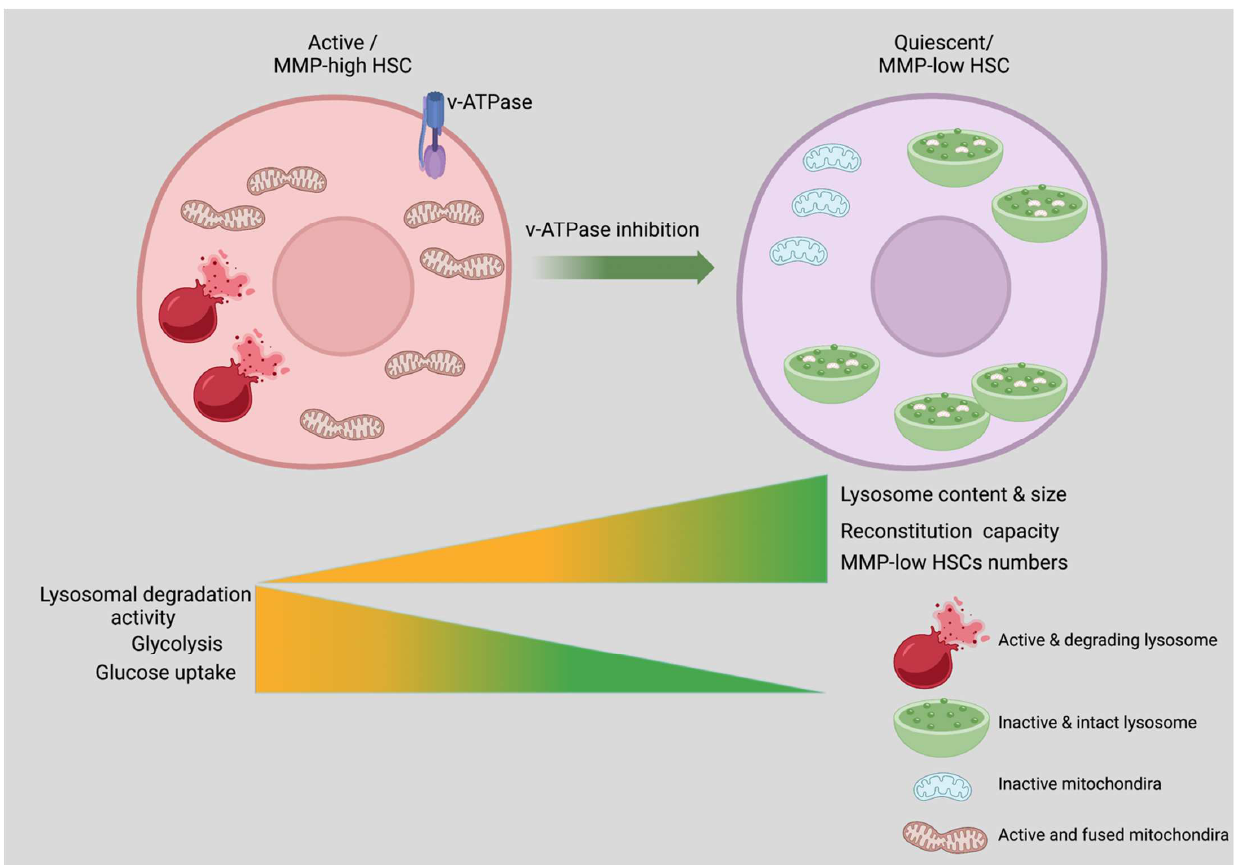
Figure 2. Lysosomal repression inhibits the activation of HSCs. Lysosomal turnover is reduced by ineffective lysosomal activity, which results in the accumulation of nutrients, including amino acids. Nutrients that are released from lysosomes maintain HSCs dormant and potency. The stem cell potency of activated HSCs is enhanced or improved by v-ATPase inhibition. Created with BioRender.com 21 September 2022.